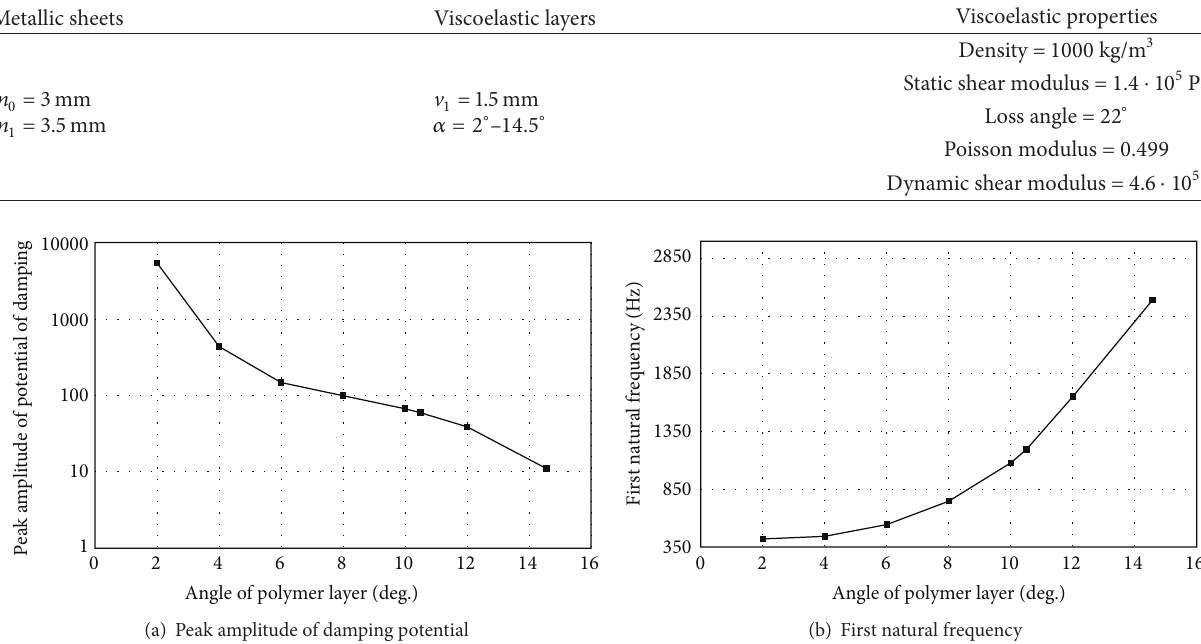
Table 7: Geometric parameters of the reference monolayer damper design.